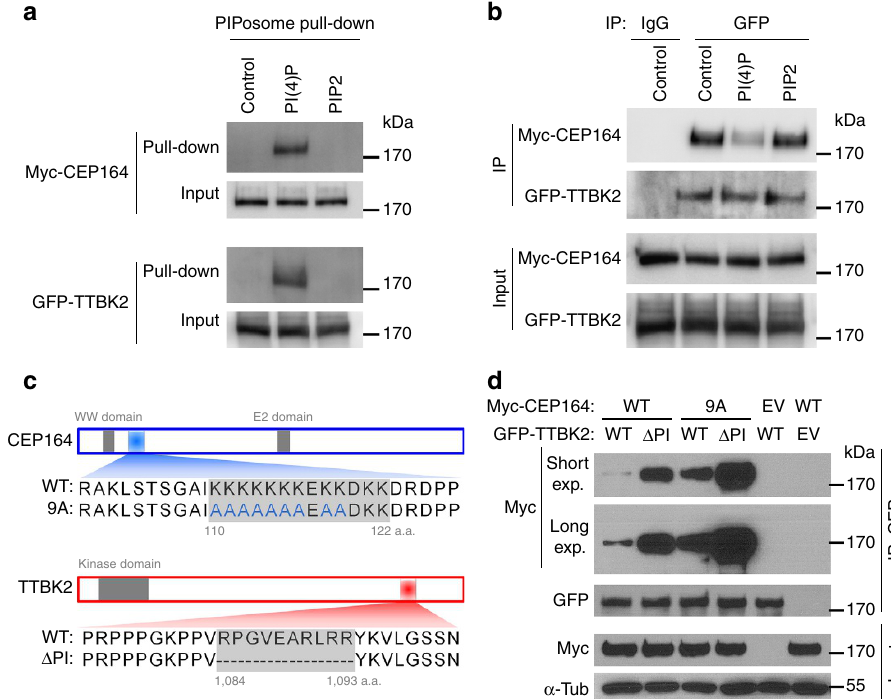
Figure 6 | PtdIns(4)P binds to CEP164 and TTBK2 and inhibits their interaction in vitro . ( a ) Cell lysates prepared from HEK293Tcells overexpressing Myc-CEP164 or GFP-TTBK2 were subjected to PolyPIPosome (PIPosome) pull-down assay with control PolyPIPosomes or PolyPIPosomes containing PtdIns(4)P (PI(4)P) or PtdIns(4,5)P 2 (PIP2). The resulting precipitates and cell lysates (Input) were immunoblotted with indicated antibodies. ( b ) HEK293T cells co-transfected with Myc-CEP164 and GFP-TTBK2 were subjected to immunoprecipitation (IP) with GFP antibody or normal mouse IgG (IgG), in the absence or presence of PI(4)P or PIP2. The resulting precipitates were examined by immunoblotting with indicated antibodies. ( c ) Schematic illustration of the consensus PI-binding motifs in CEP164 and TTBK2. The PI-binding-deficient CEP164 or TTBK2 were generated by mutating or deleting the basic amino acids in these motifs, respectively. ( d ) HEK293Tcells co-transfected with indicated combination of wild type (WT) or mutated (9A) Myc-CEP164 and wild type or mutated ( D PI) GFP-TTBK2 were subjected to IP with anti-GFP antibody. The resulting precipitates and cell lysates (Input) were immunoblotted with indicated antibodies. EV, empty vector; long exp., long exposure; ; short exp., short exposure; a -Tub, a